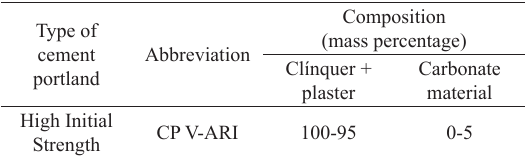
Table 1. Composition of High Initial Strength Portland